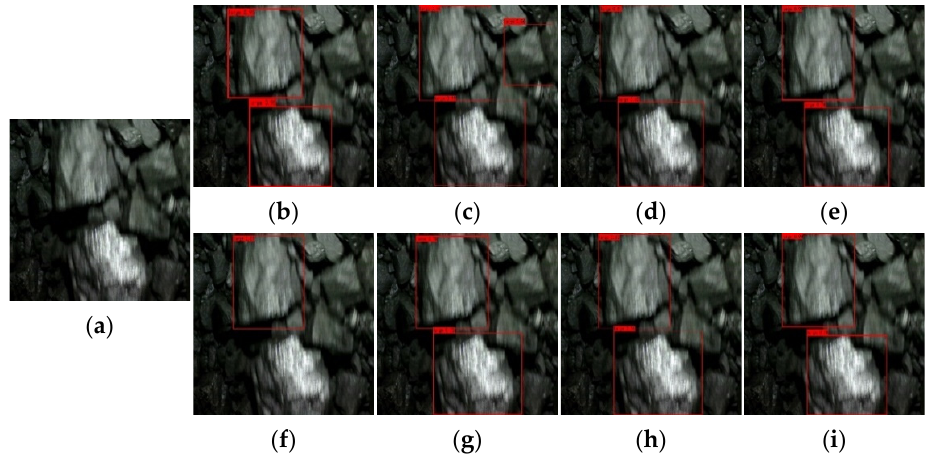
Figure 10. Results of big coal block detection via different networks—the second image. ( a ) origin;